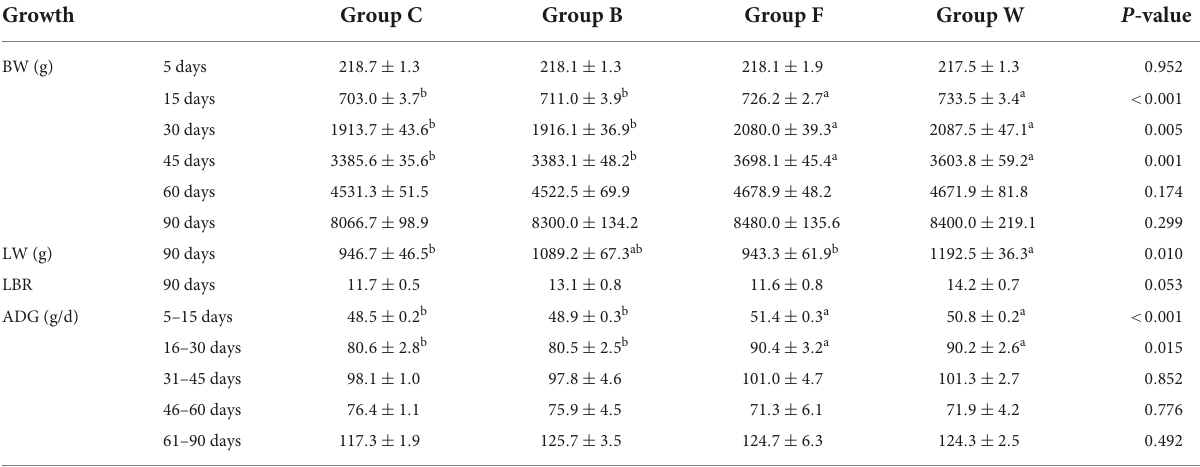
TABLE 2 Effects of brewers’ spent grain (BSG) on the growth performance in four groups of Landes geese (i.e., groups C, B, F, and W). Growth